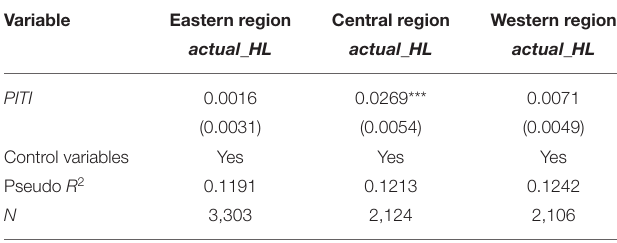
TABLE 11 | Ologit regression results of different regions.